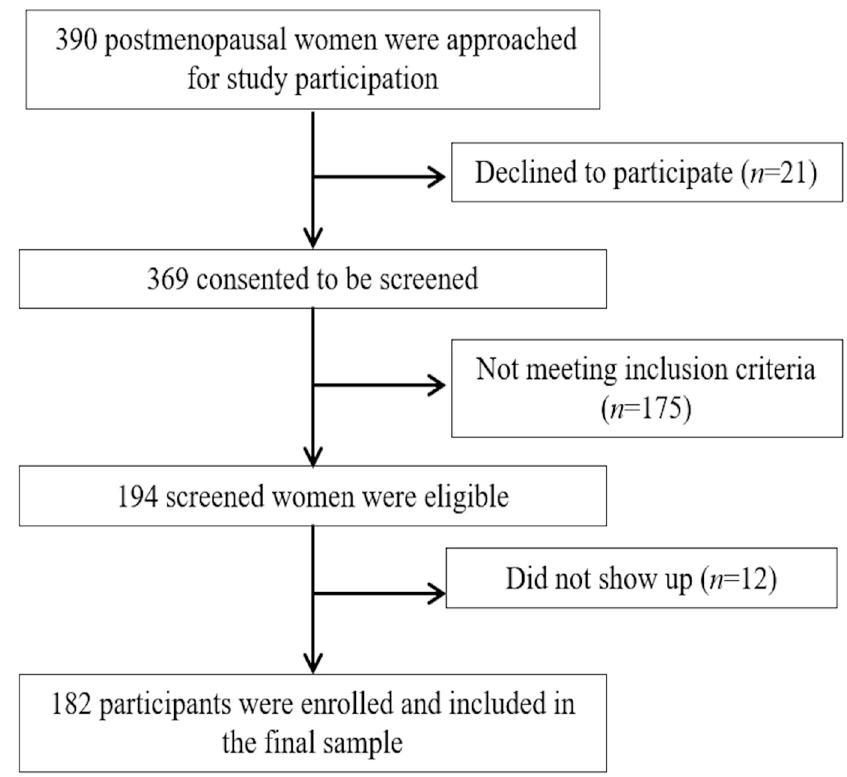
Figure 1. Flow diagram of study design.